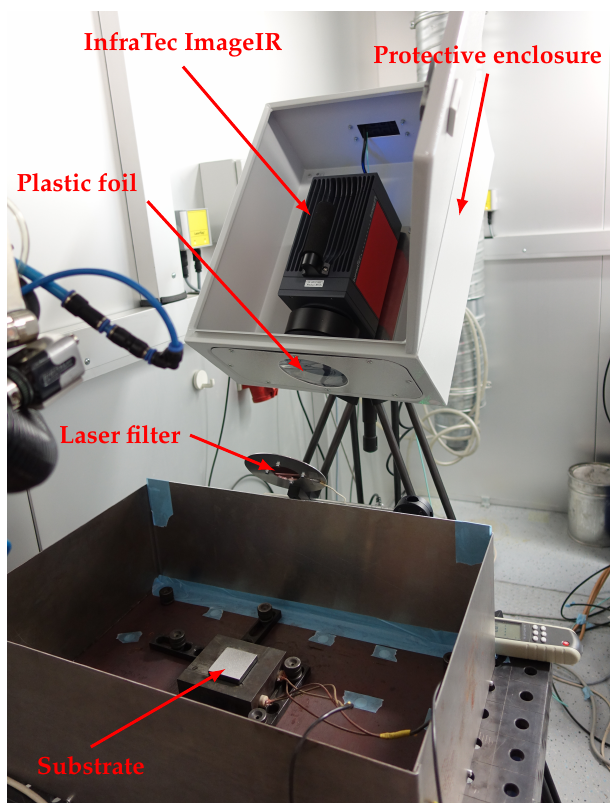
Figure 2. Camera setup during the LMD process. The protective enclosure is only opened for the photography of the